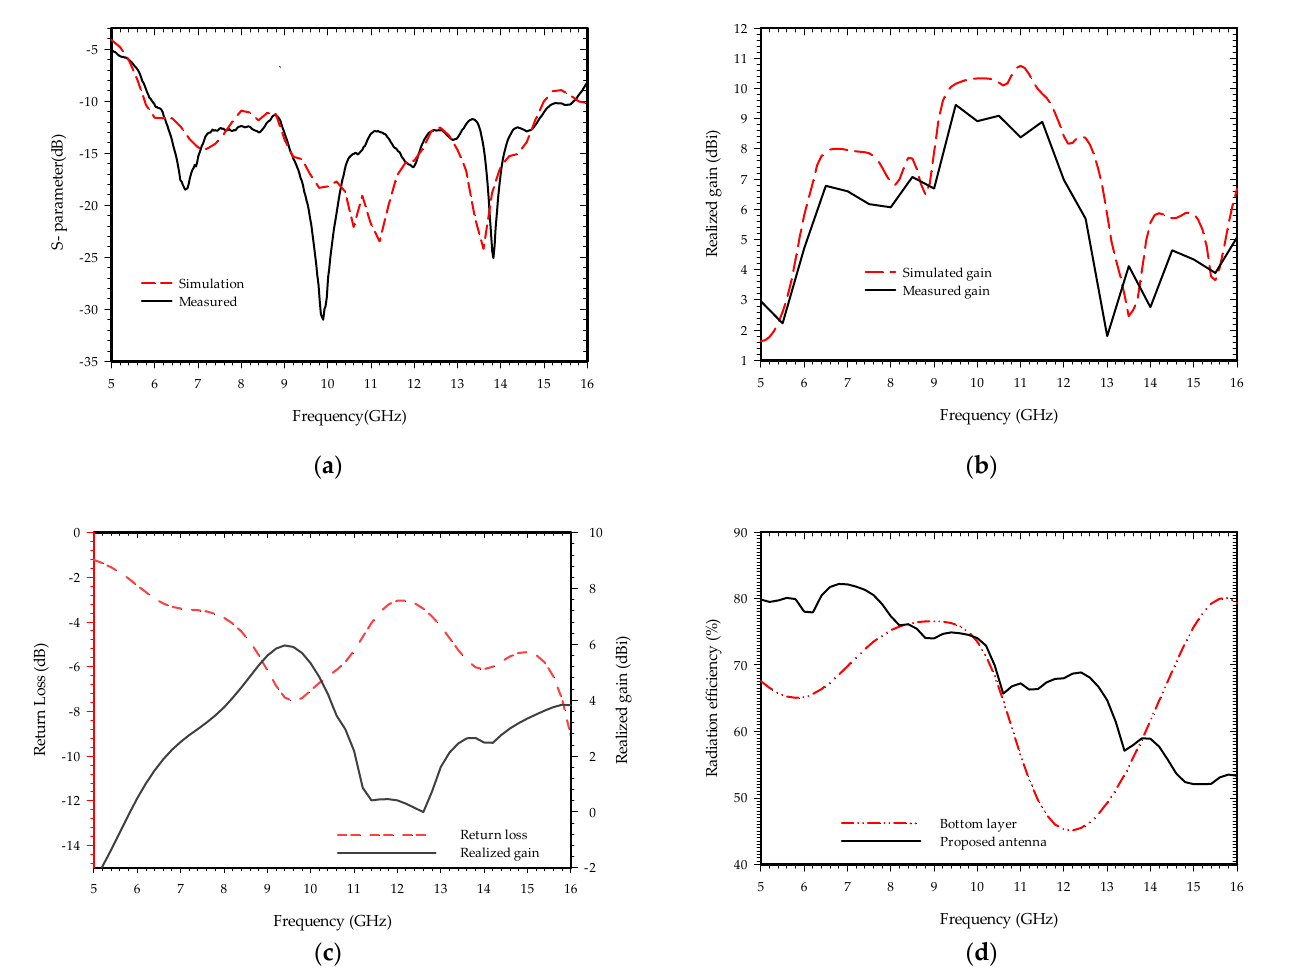
Figure 3. The simulated and measured result of the proposed antenna; ( a ) Return loss; ( b ) Realized gain; ( c ) Simulated return loss and realized gain of the bottom substrate feed layer; ( d ) Radiation efficiency of the proposed antenna and bottom substrate feed layer.